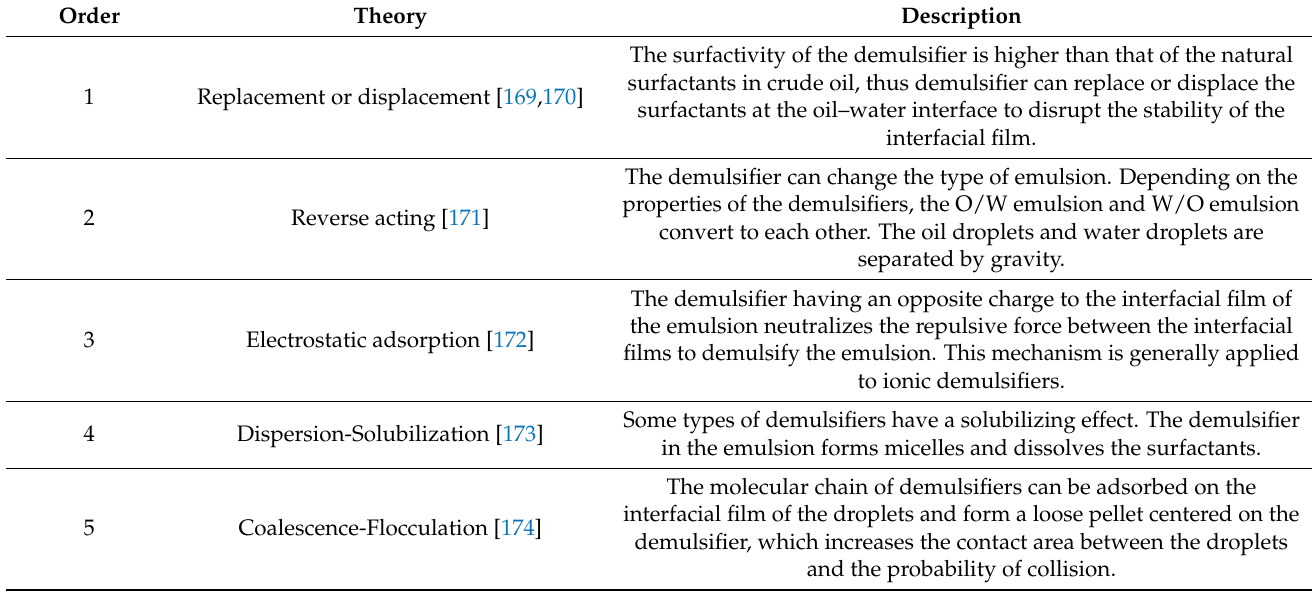
Table 10. The four common theories of chemical demulsification.